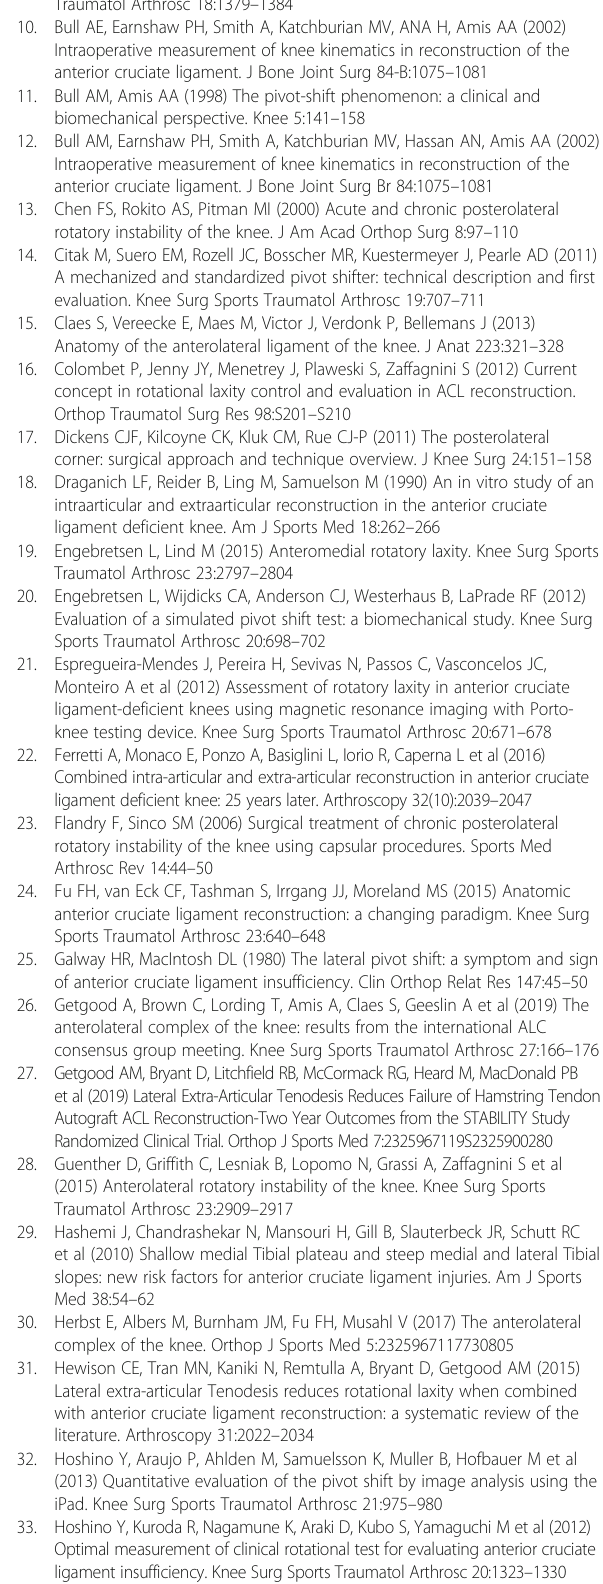
Abbreviations ACL: Anterior cruciate ligament; ACL-R: Anterior cruciate